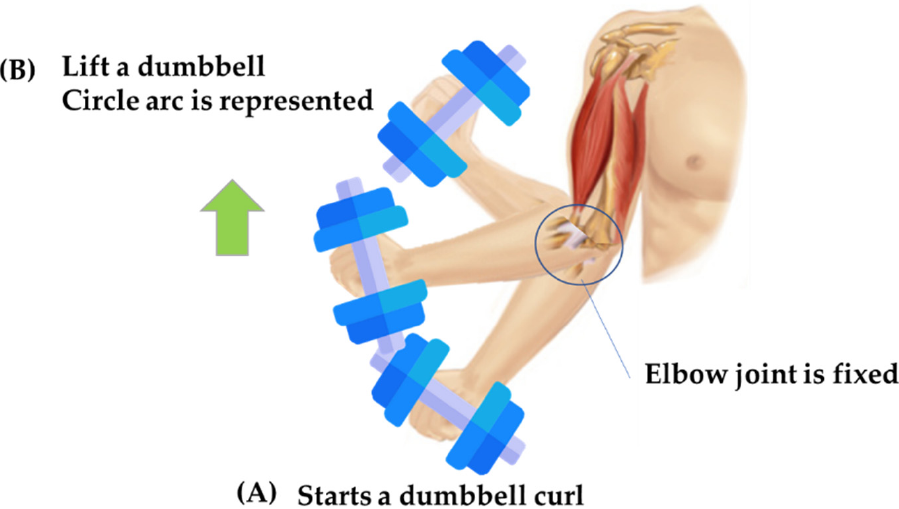
Figure 3. Exercise process. ( A ) Starts current dumbbell curl where the elbow joint is fixed as a stand- ard joint. ( B ) A user lifts a dumbbell, and the movement trajectory is represented as a circular